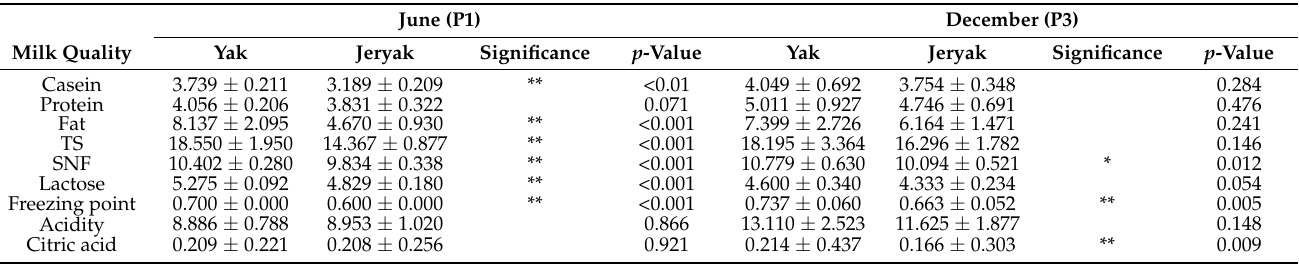
Table 1. Comparison between the milk quality of yak and Jeryak milk sampled in June (P1: Jeryak in June vs. Yak in June) and December (P3: Jeryak in December vs. Yak in